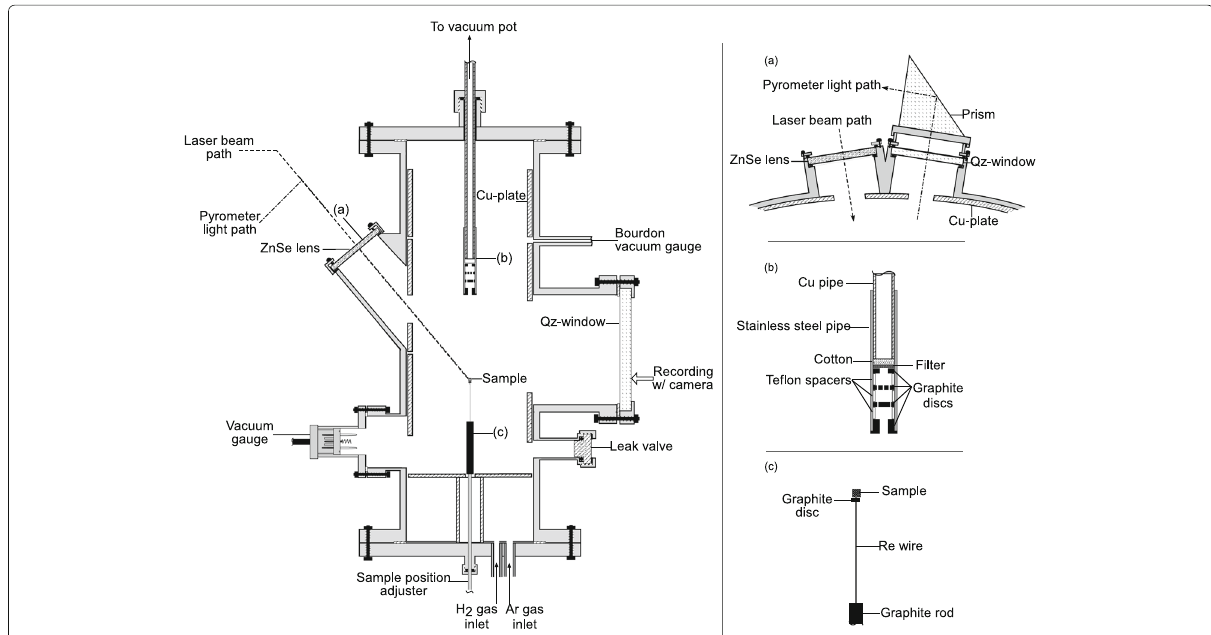
Fig. 1 Schematic diagram of the experimental apparatus. a Shows arrangement of the laser and pyrometer light paths. b Shows system for collecting condensed particles. c Shows sample holding system. Evacuation line is omitted in the